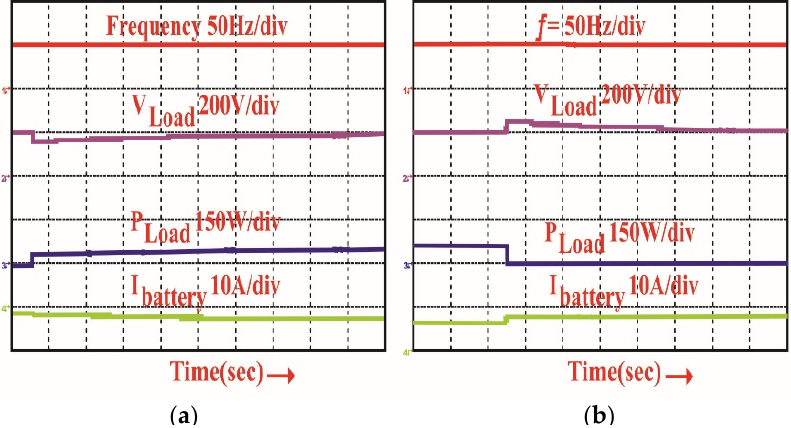
Figure 14. The performance of the hybrid micro grid ( a ) load cutting condition; ( b ) Load removing condition.